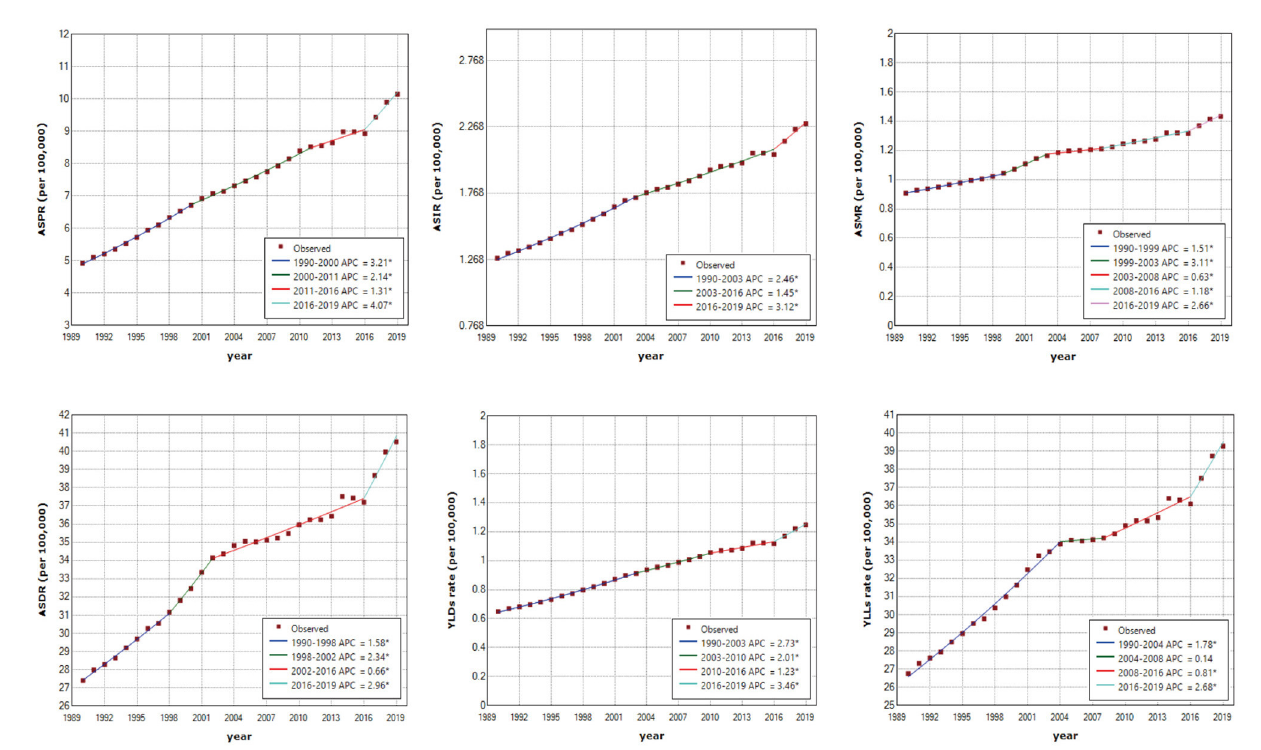
FIGURE4 Joinpoint regression analysis of age-standardized prevalence rate (ASPR), age-standardized incidence rate (ASIR), age-standardized mortality rate (ASMR), age-standardized disability-adjusted life-years rate (ASDR), age-standardized years lived with disability rate (YLDs rate) and age-standardized years of life lost rate (YLLs rate) in China from 1990 to 2019. An asterisk indicates that the annual percentage change is statistically significantly different from zero at the α = 0.05 level.